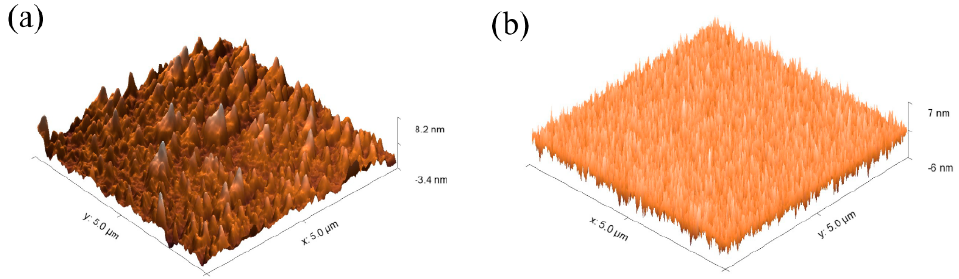
Figure 2. AFM images of thin films: ( a ) IZO without UV treatment, ( b ) IZO with UV treatment. The XRD patterns of IZO thin films are presented in Figure 3a. There are no obvious peaks in this pattern, indicating the amorphous structure for thin films. The amorphous phase can contribute to the formation of the semiconductor layer with a smooth surface and excellent uniformity, which is beneficial for the fabrication of TFT devices. The results are consistent with the AFM